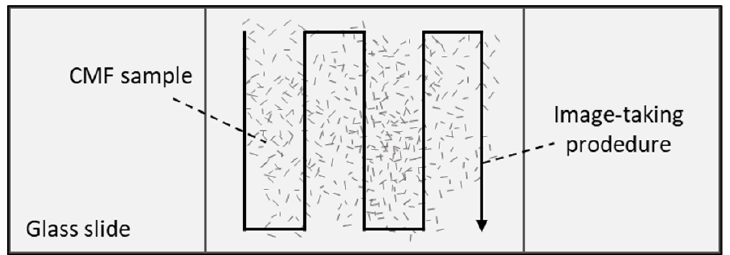
Figure 1. Image acquisition procedure to obtain the lengths of the cellulose microfibers (CMFs). The morphologies of RS, CMFs, and the cross-sections of the cryo-fractured films obtained by immersion in liquid nitrogen were evaluated using a Field Emission Scanning Electron Microscope (FESEM) equipped with focused ion gun (AURIGA Compact, Zeiss, Oxford Instruments). The conditioned samples (P 2 O 5 at 25 ± 2 ◦ C for 1 week) were covered with a platinum layer (EM MED020 sputter coater, Leica Biosystems, Barcelona, Spain), and the images were taken at 2.0 kV acceleration voltage. The SmartTiff program (version 2, Zeiss, Oxford Instruments, Abingdon, UK) was used to measure the particle width ( w ) a minimum of 60